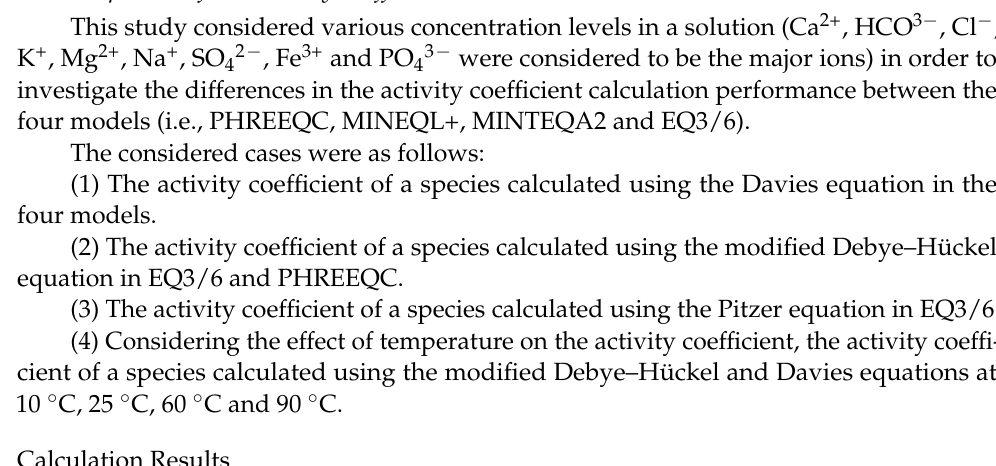
Figure 10. The activity coefficients calculated by the Davies equation using the same thermodynamic database of the four models.